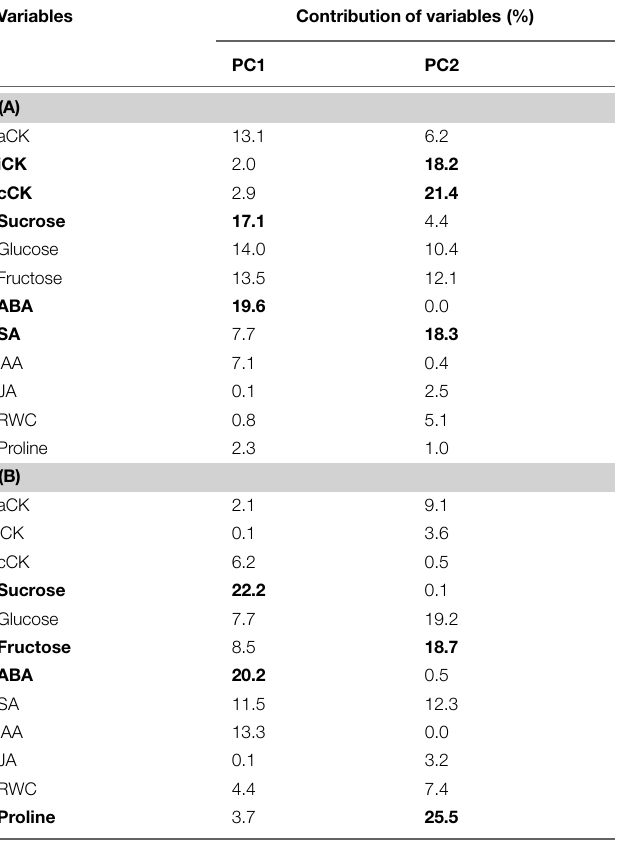
TABLE 2 | Contribution of the 12 physiological variables to the formation of principal components (PC) 1 and 2 of the PCA of the datasets A (A) and B